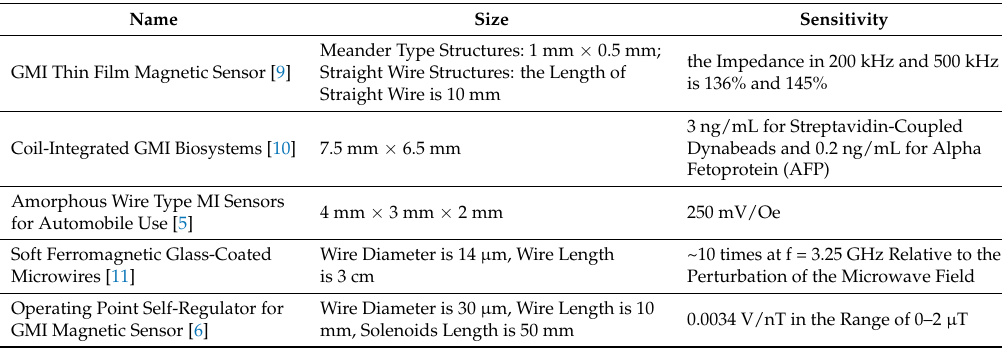
Table 1. Summary of various amorphous wire